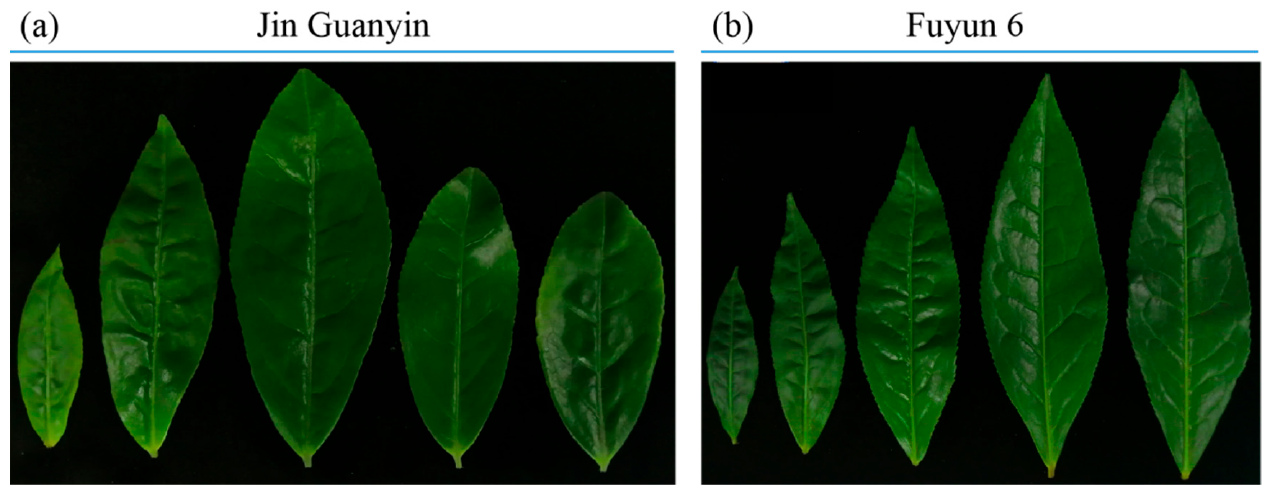
Figure 1. Fresh tea leaves of Jin Guanyin ( a ) and Fuyun 6 ( b ).